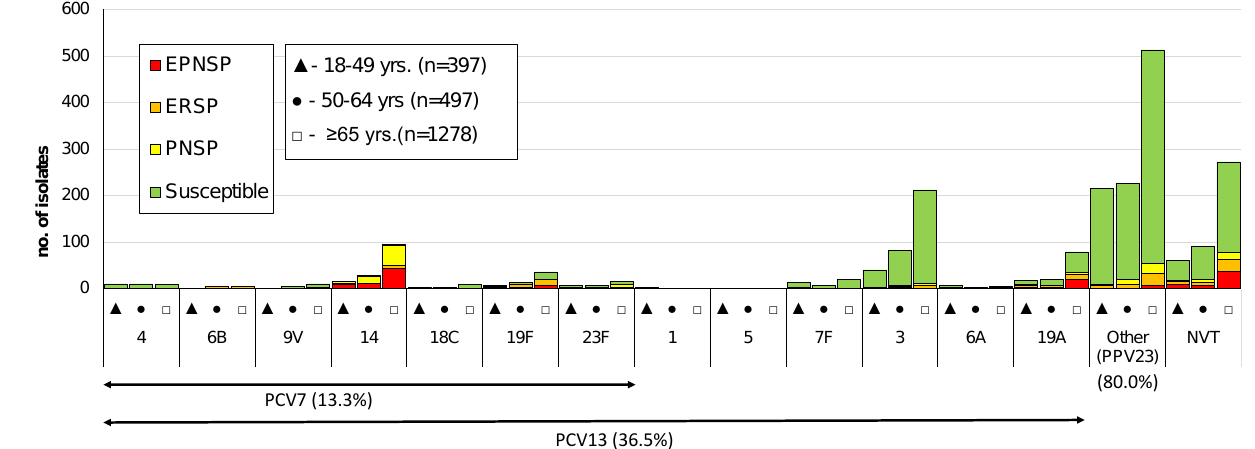
Figure 1. Serotypes of isolates causing invasive pneumococcal disease in adult patients ( ≥ 18 years) in Portugal from 2015 to 2018. The number of isolates expressing each serotype in each of the considered age groups is indicated. Isolates recovered from patients 18–49, 50–64, and ≥ 65 years old are indicated by black triangles, black circles, and open squares, respectively. Isolates presenting both erythromycin resistance and penicillin non-susceptibility (EPNSP) are represented by red bars. Erythromycin-resistant pneumococci (ERP) is indicated by orange bars. Penicillin non-susceptible isolates (PNSP) are indicated by yellow bars. Isolates susceptible to both penicillin and erythromycin are represented by green bars. In one case in the ≥ 65 years age group, the antimicrobial susceptibility was unknown because the diagnosis was made by molecular methods and is not represented in Figure 1. The serotypes included in the 7-valent conjugate vaccine (PCV7) and the 13-valent conjugate vaccine (PCV13) are indicated by the arrows. NVT: non-vaccine serotypes; other: the additional serotypes included in the 23-valent polysaccharide vaccine (PPV23) and not present in PCV13.